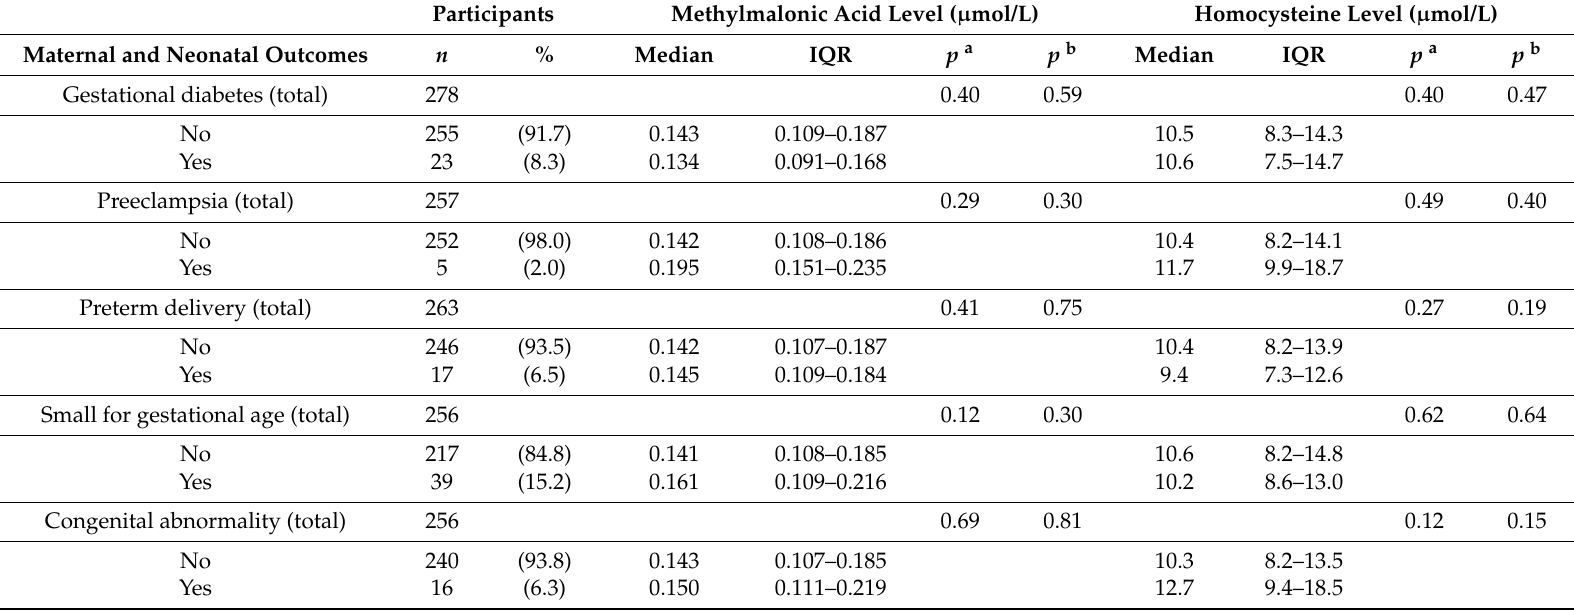
Table 3. Association between serum methylmalonic acid and homocysteine levels and maternal and neonatal